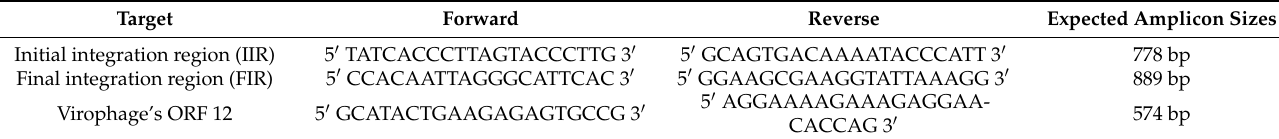
Table 1. Primer sequences used in PCR